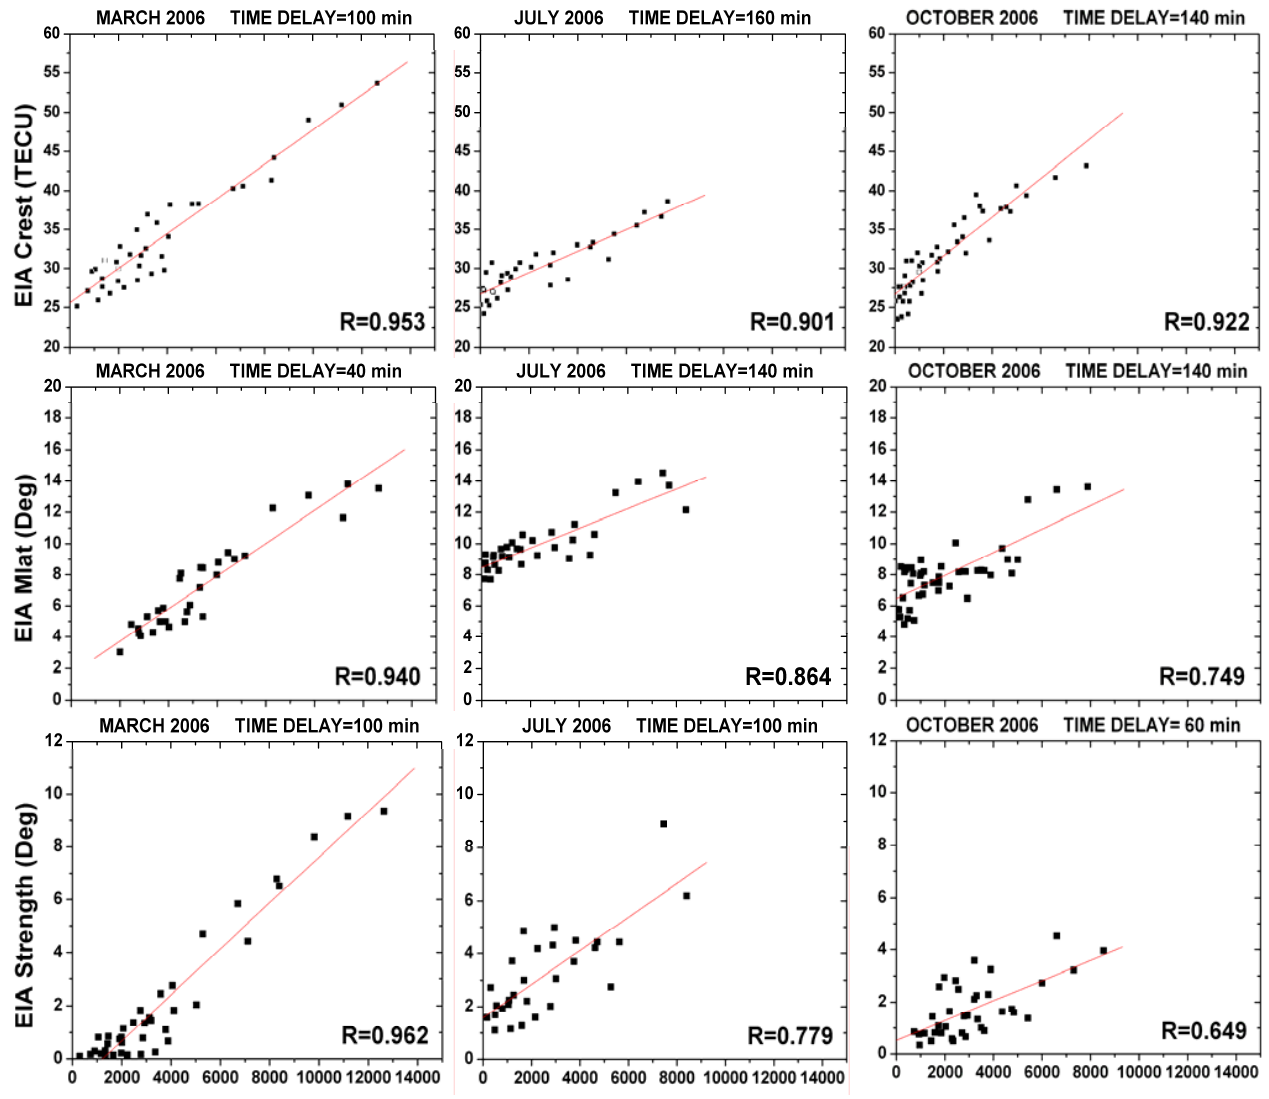
Fig. 2. Scatter plots between IEEJ and EIA parameters, showing the maximum correlation for different